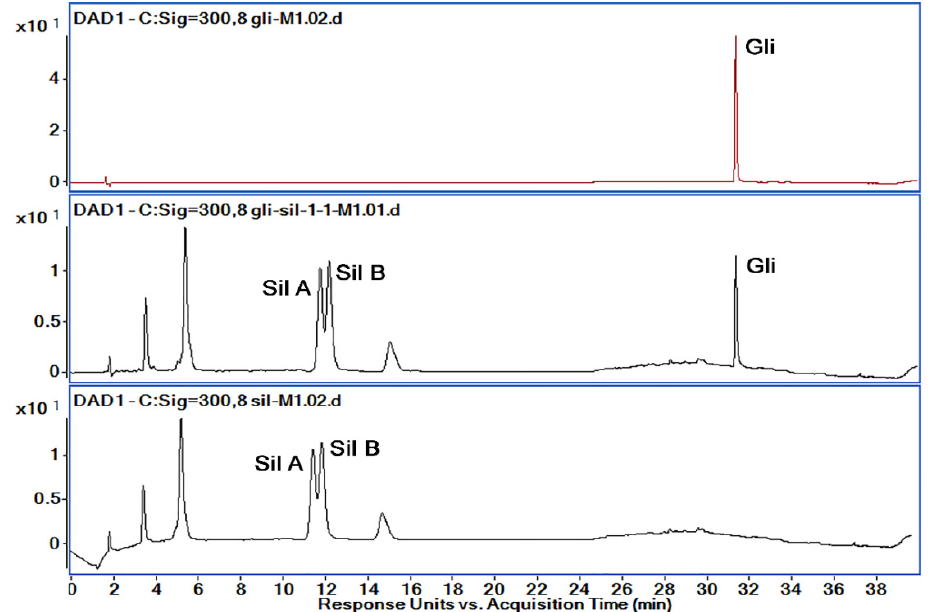
10 of 21 Figure 4. The CS and CS-Gli-Sil swelling degree (%): ( A ) in distilled water; ( B ) in simulated gastric fluid. 3.5. HPLC-ESI-MS Method Development and Optimization All methods used for the separation and identification of the active substances (Gli,